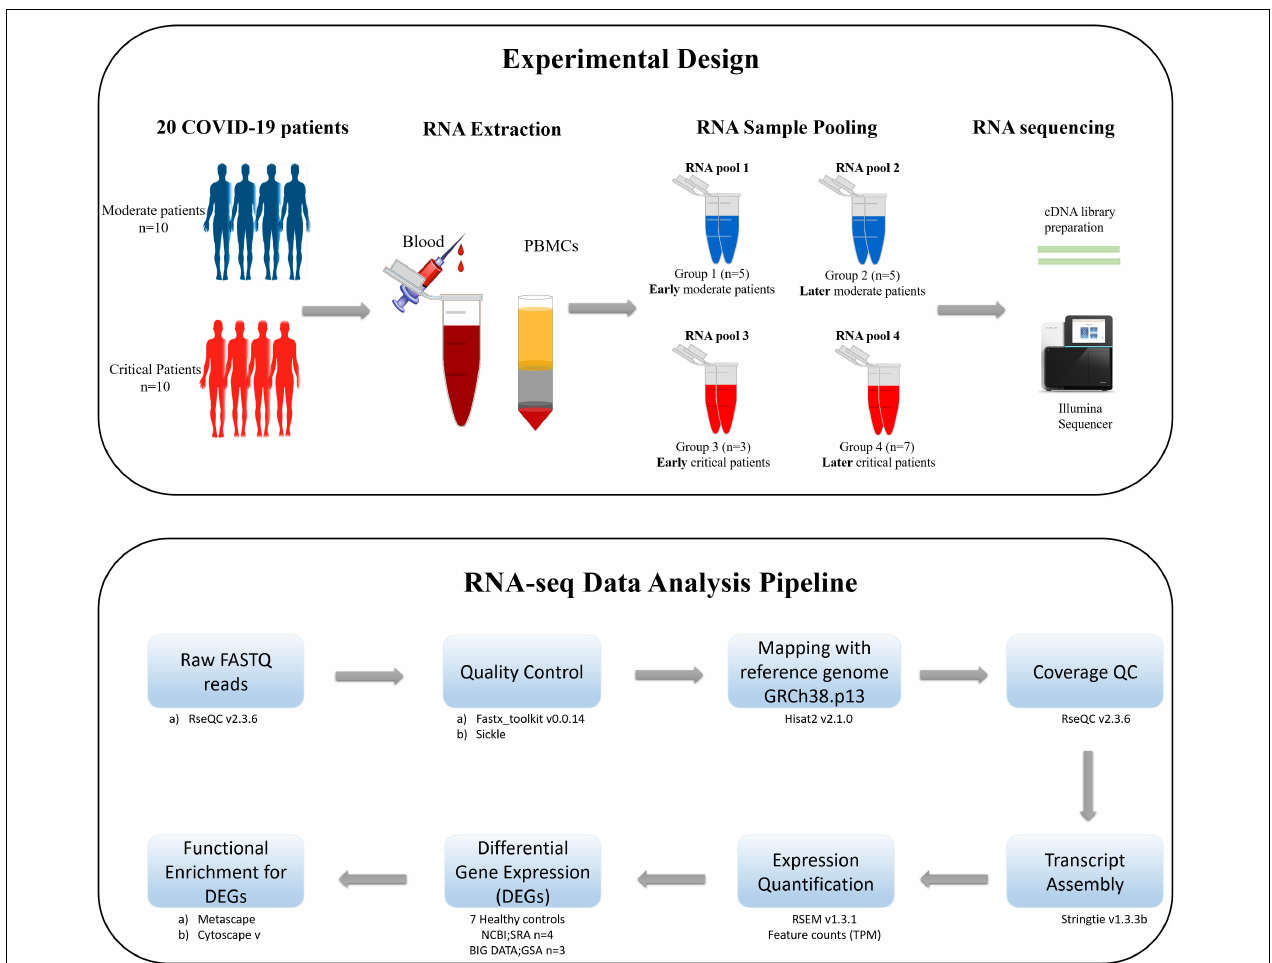
FIGURE 1 | The schematic illustration of the pipeline adopted for the current study. The upper section of the figure illustrates the experimental design, isolation of PBMCs from the blood of COVID-19 patients, distribution of patients in each RNA pool, and sequencing method carried out for the current study. The lower section of the figure describes the data analysis pipeline, tools, and packages executed for this